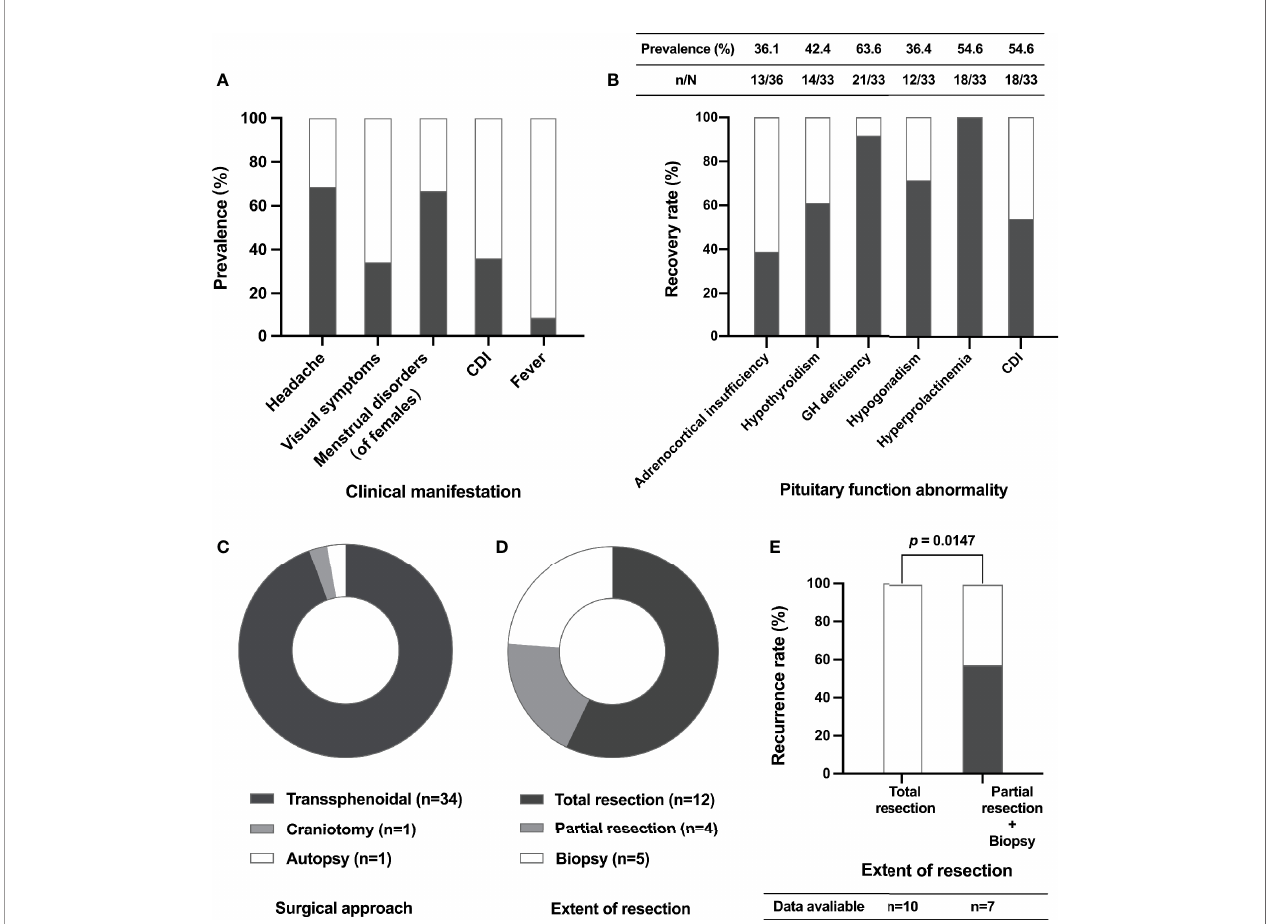
FIGURE 3 | Clinical characteristics, surgical aspects and recurrence of XHP cases. The prevalence of different clinical manifestations of XHP patients (A) ; the prevalence of pituitary function abnormalities before surgery (table) and the recovery rate of pituitary function after surgery (histogram) (B) ; the composition of different surgical approaches (C) ; the composition of different extents of lesion resection (D) ; the relationship between recurrence and extent of resection (E) . CDI, central diabetes insipidus; GH, growth